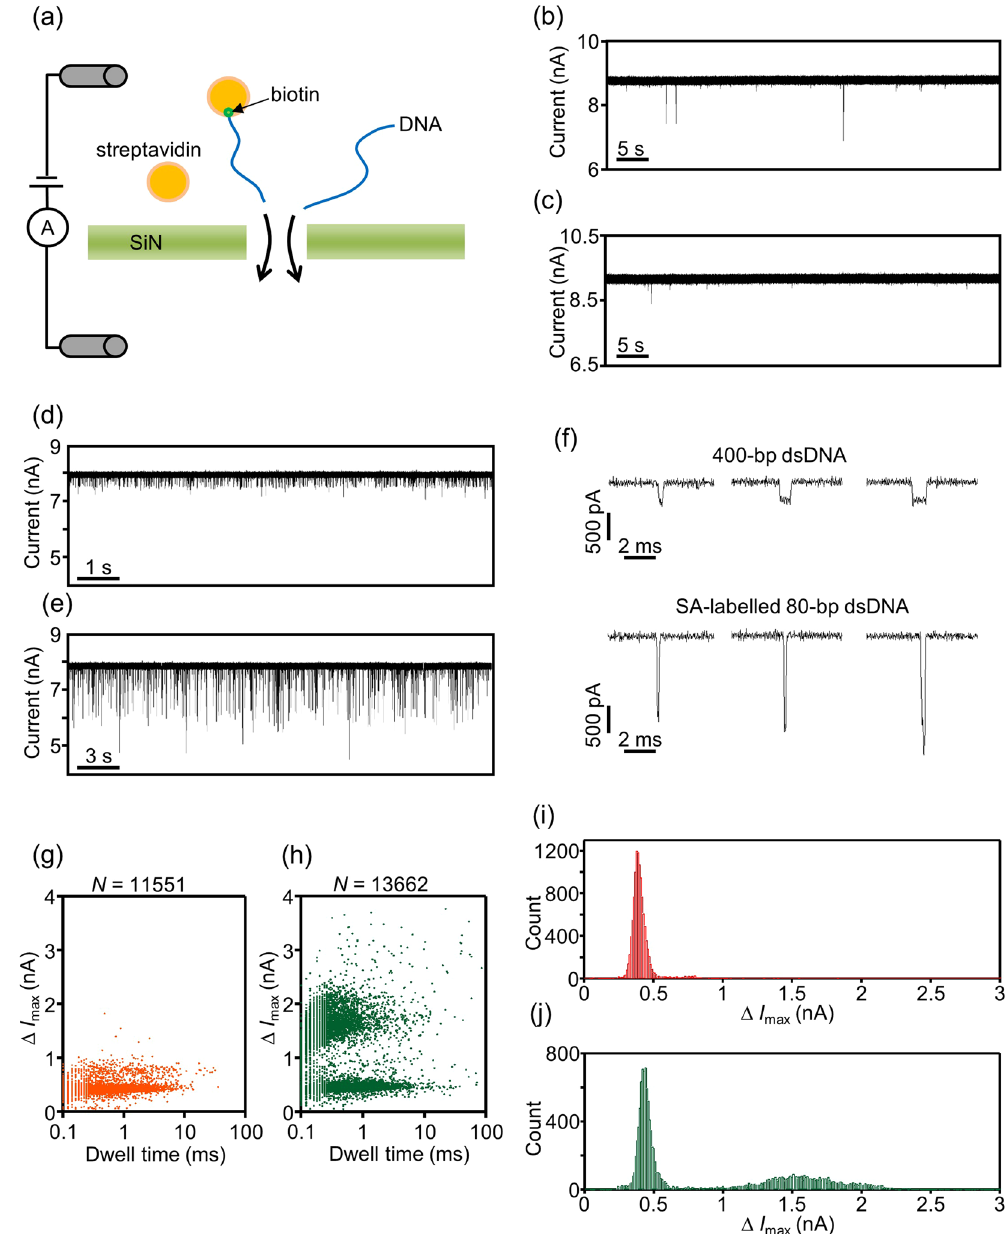
Figure 7. Detection of the passage of SA-labelled and non-labelled dsDNA through nanopores. ( a ) Schematic illustration of the detection of SA-labelled and non-labelled dsDNA passing through a nanopore. The voltage applied was 0.2 V ( V trans = 0.2 V and V cis = 0 V). ( b , c ) Time traces of ionic current through nanopores fabricated in ( b ) 20-nm-thick and ( c ) 14-nm-thick SiN membranes. The solution in the cis chamber was 1 M KCl with 100 nM SA. The estimated diameters of the nanopores were ( b ) 10.4 nm and ( c ) 10.2 nm. ( d,e ) Time traces of ionic current through a nanopore fabricated in a 20-nm-thick SiN membrane. The solution in the cis chamber was ( d ) 1 M KCl with 15 nM 400-bp dsDNA. Then, the solution was incompletely displaced by ( e ) 1 M KCl with 15 nM SA-labelled 80-bp dsDNA. The estimated diameter of the nanopore was 9.8 nm. ( f ) Magnified views of typical ionic-current blockades derived from 400-bp dsDNA and SA-labelled 80-bp dsDNA passing through the nanopore. ( g,h ) Scatter plots of Δ I max and dwell time for translocation events of ( g ) 400-bp dsDNA and ( h ) SA-labelled 80-bp dsDNA and 400-bp dsDNA. ( i,j ) Histograms of Δ I max for translocation events of ( g ) 400-bp dsDNA and ( h ) SA-labelled 80-bp dsDNA and 400-bp